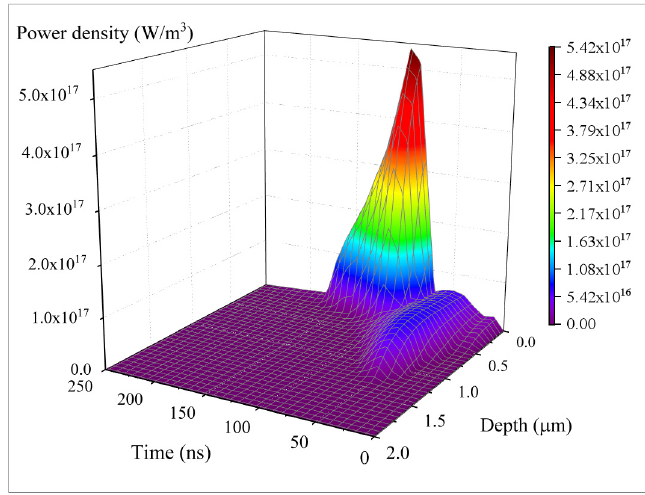
Figure 4. Power density distribution of 100 A/cm 2 IPIB in IN718.